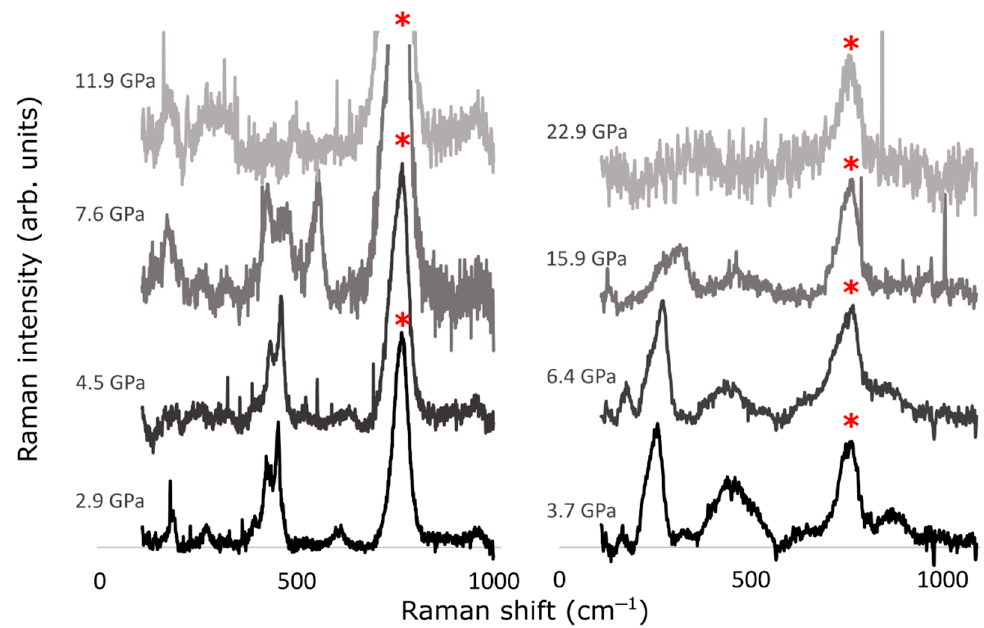
Figure 3. Raman spectra of α -K 2 AgF 4 ( left ) and β -K 2 AgF 4 ( right ) measured with 514 nm laser at increasing pressure, with pressure values labelled next to each spectrum. Red asterisks indicate bands originating from FEP used as pressure medium.